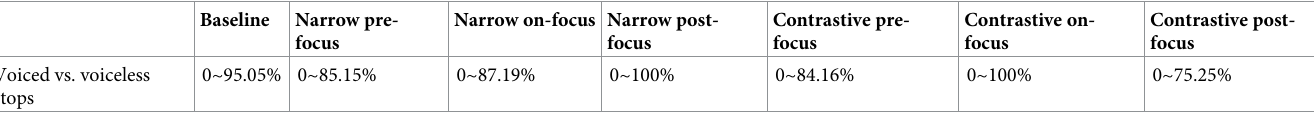
Table 4. Significantly different regions between voiceless and voiced stops in various discourse conditions for (Japanese monosyllables). Baseline Narrow pre- Narrow on-focus Narrow post- Contrastive pre- Contrastive on- Contrastive post- focus focus focus focus